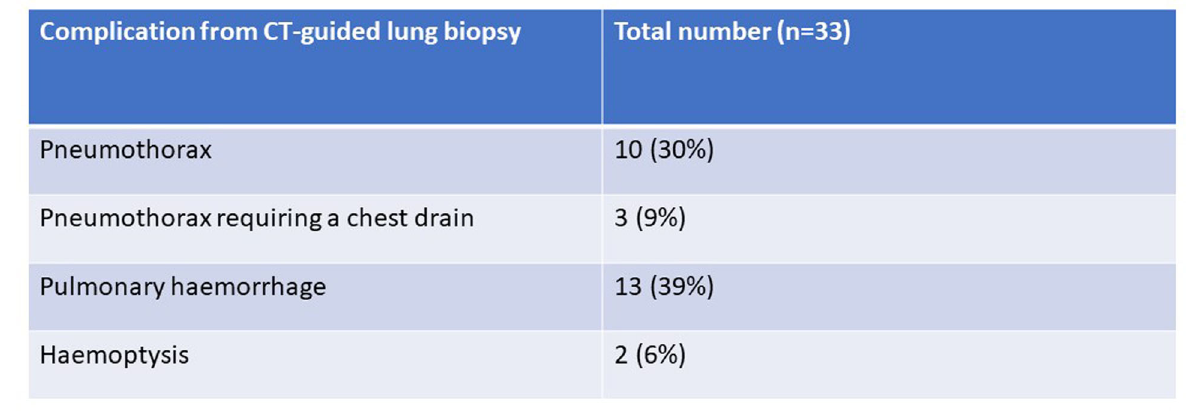
Table 3 Complications from CT-guided lung